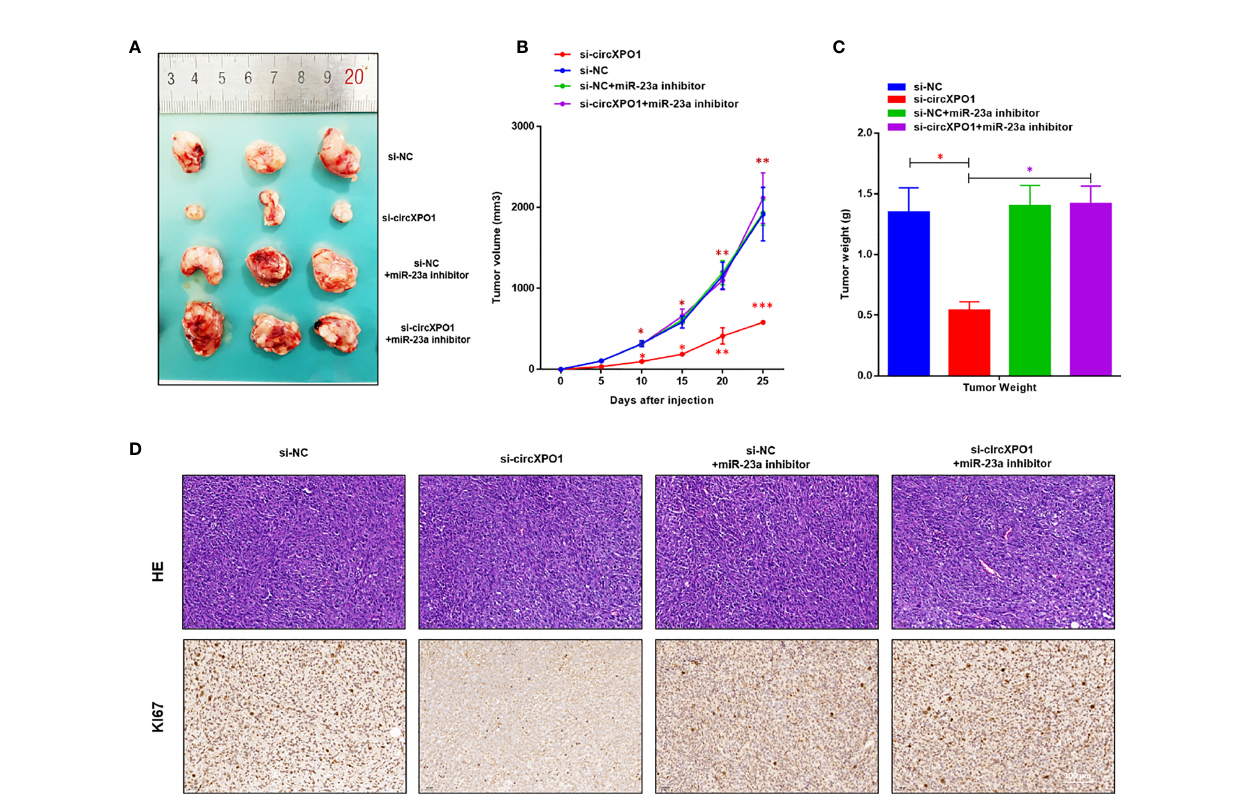
FIGURE 5 | circXPO-1 promoted prostate tumor growth by sponging miR-23a in vivo . Mice were subcutaneously inoculated with 1 × 10 7 PC-3 cells transfected with si-circXPO1, si-NC, si-NC + miR-23a inhibitor, or si-circXPO1 + miR-23a inhibitor into a single fl ank. (A) Images of the tumors. (B) The growth curve of the tumors. The tumor volume was calculated as (length × width 2 )/2. (C) Mice were euthanized 25 days after inoculation. The tumors were immediately collected and weighed. Data are expressed as the means ± SD. * P < 0.05, ** P < 0.01, *** P < 0.001; n = 3. (D) The tumor tissue samples were subjected to Hematoxylin & eosin staining (upper panel) and immunohistochemical staining for Ki67 (lower